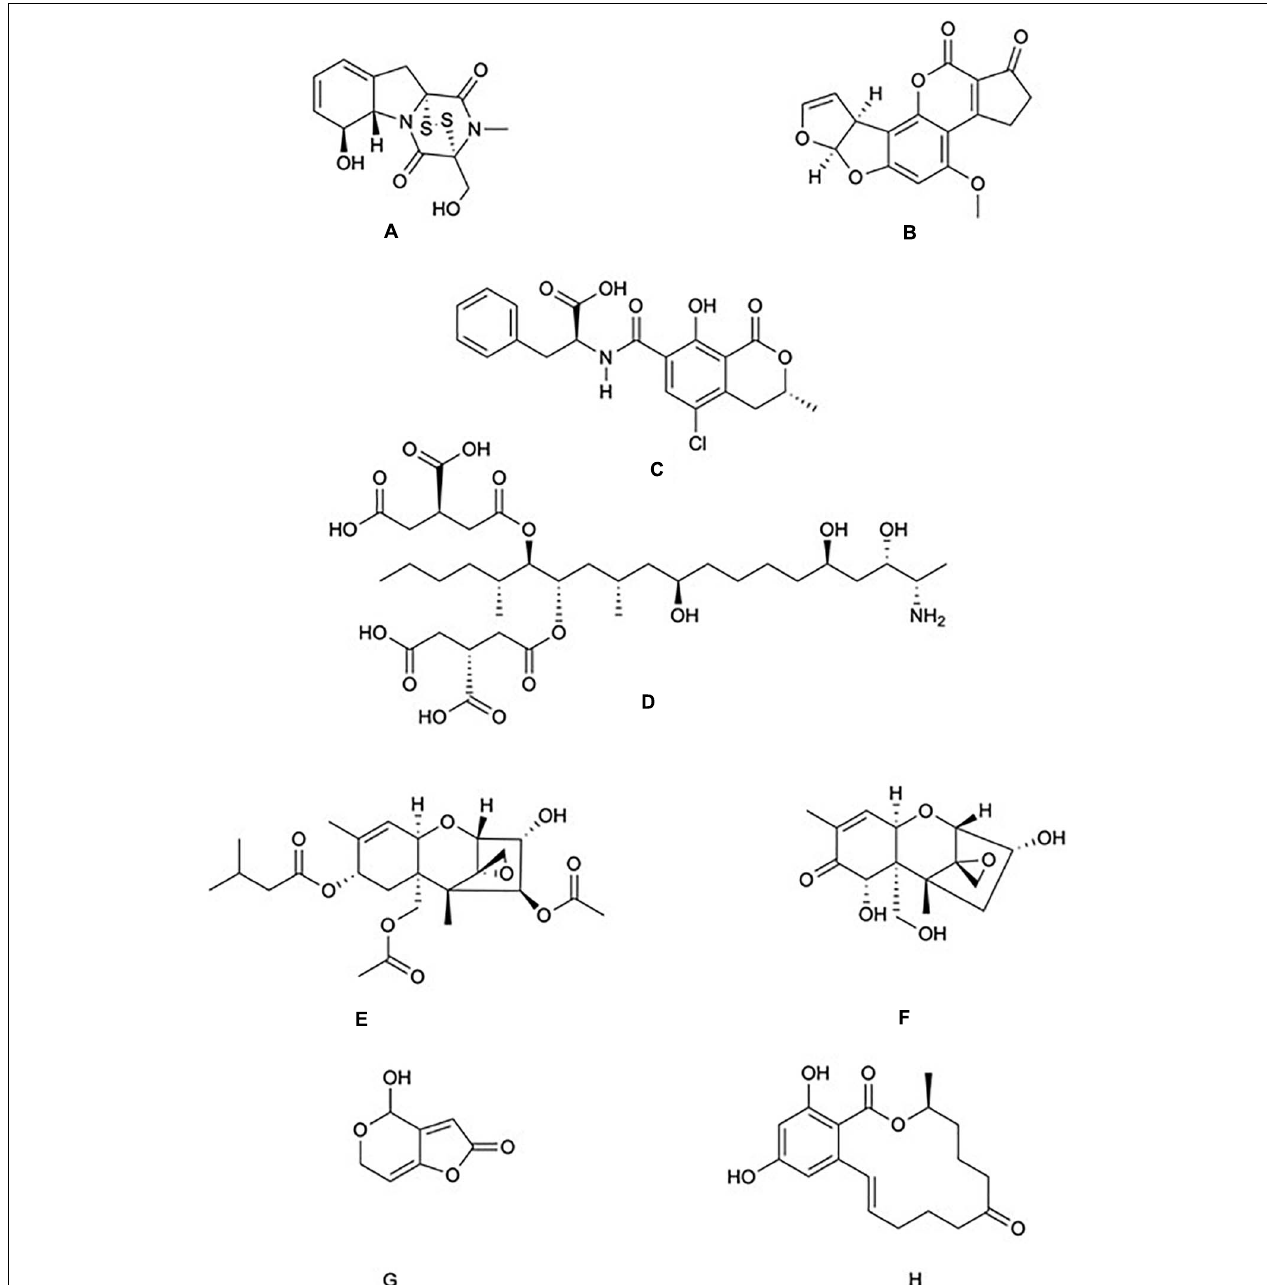
FIGURE 1 | Chemical structure of common mycotoxins. (A) Gliotoxin (C 13 H 14 N 2 O 4 S 2 ) is a member of the epipolythiodioxopiperazine family of mycotoxins and is produced by Aspergillus fumigatus . (B) Aflatoxin B1 (C 17 H 12 O 6 ) produced by A. flavus and A. parasiticus . (C) Ochratoxin A (C 20 H 18 CINO 6 ) is a phenylalanine derivative produced by several species of the genera Aspergillus and Penicillium . (D) Fumonisin B1 (C 34 H 59 NO 15 ) is characterised by diester and triol functional groups and is produced by species of the genus Fusarium . The trichothecenes family include: (E) The type A trichothecene T-2 (C 24 H 34 O 9 ) and (F) The type B trichothecene Deoxynivalenol (C 15 H 20 O 6 ). T-2 and Deoxynivalenol are produced by numerous genera of fungi including Fusarium , Stachybotrys , and Trichoderma . (G) Patulin (C 7 H 6 O 4 ) is produced by species of the genera Aspergillus and Penicillium . (H) Zearalenone (C 18 H 22 O 5 ) is produced by species of the genera Fusarium and Gibberella